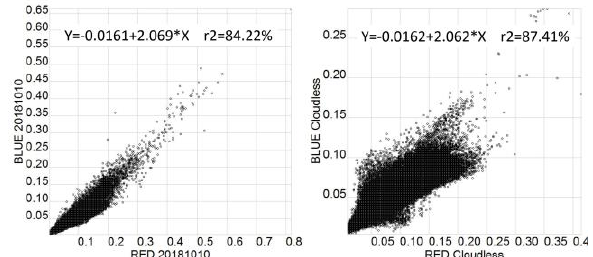
Figure 17. Correlation analysis between Blue band (y axis) and Red band (x axis), for the 20 km sampling area. (Left) Original image taken at October 10, 2018; (Right) Cloudless image obtained by means of the M2CTool Also, the spectral profile of reflectance at the Blue band, reveals that, even for this case, at certain points of the image some thin clouds or haze is present. Again, the reconstructed image shows lower values with respect to the reference image, along a transect supposedly affected by atmospheric concerns (Figure 18).